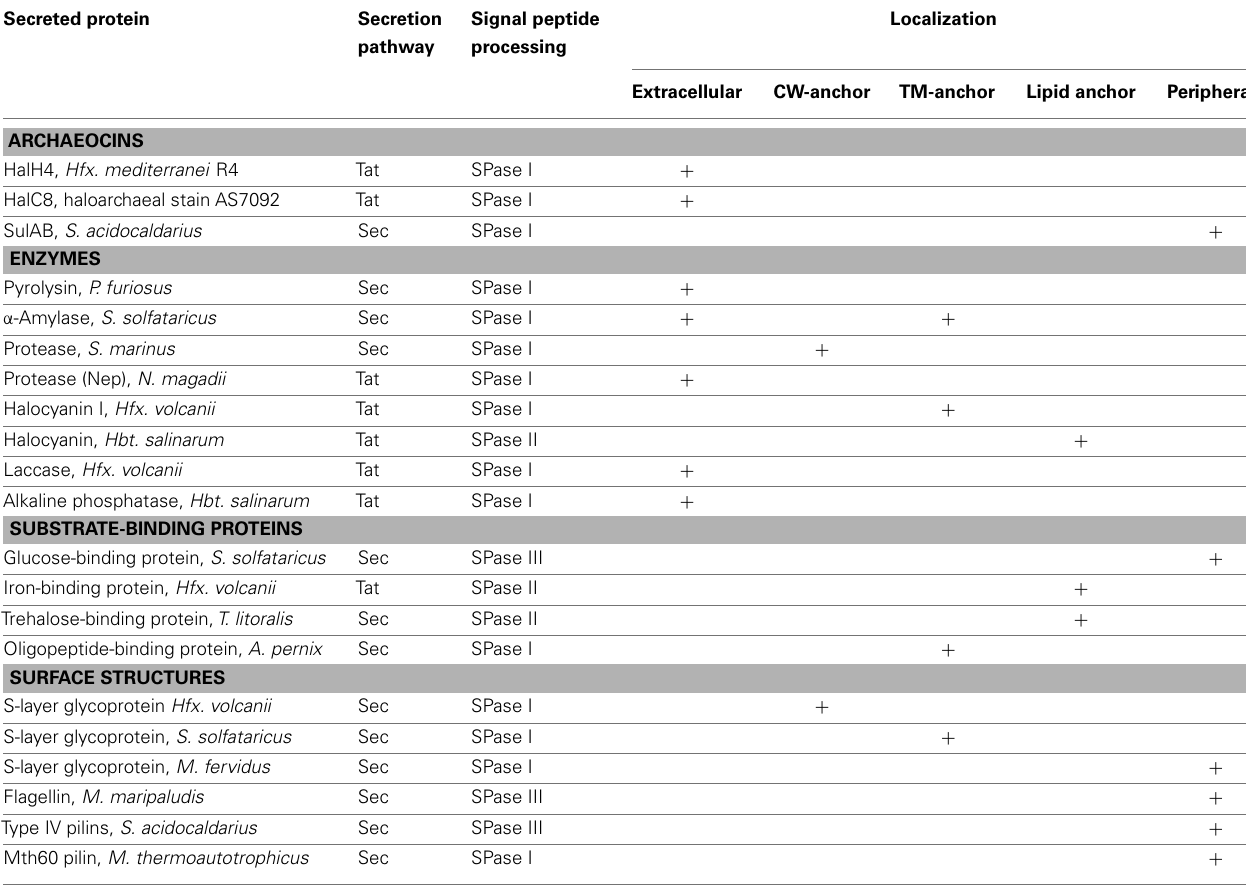
Table 2 |Archaeal secreted